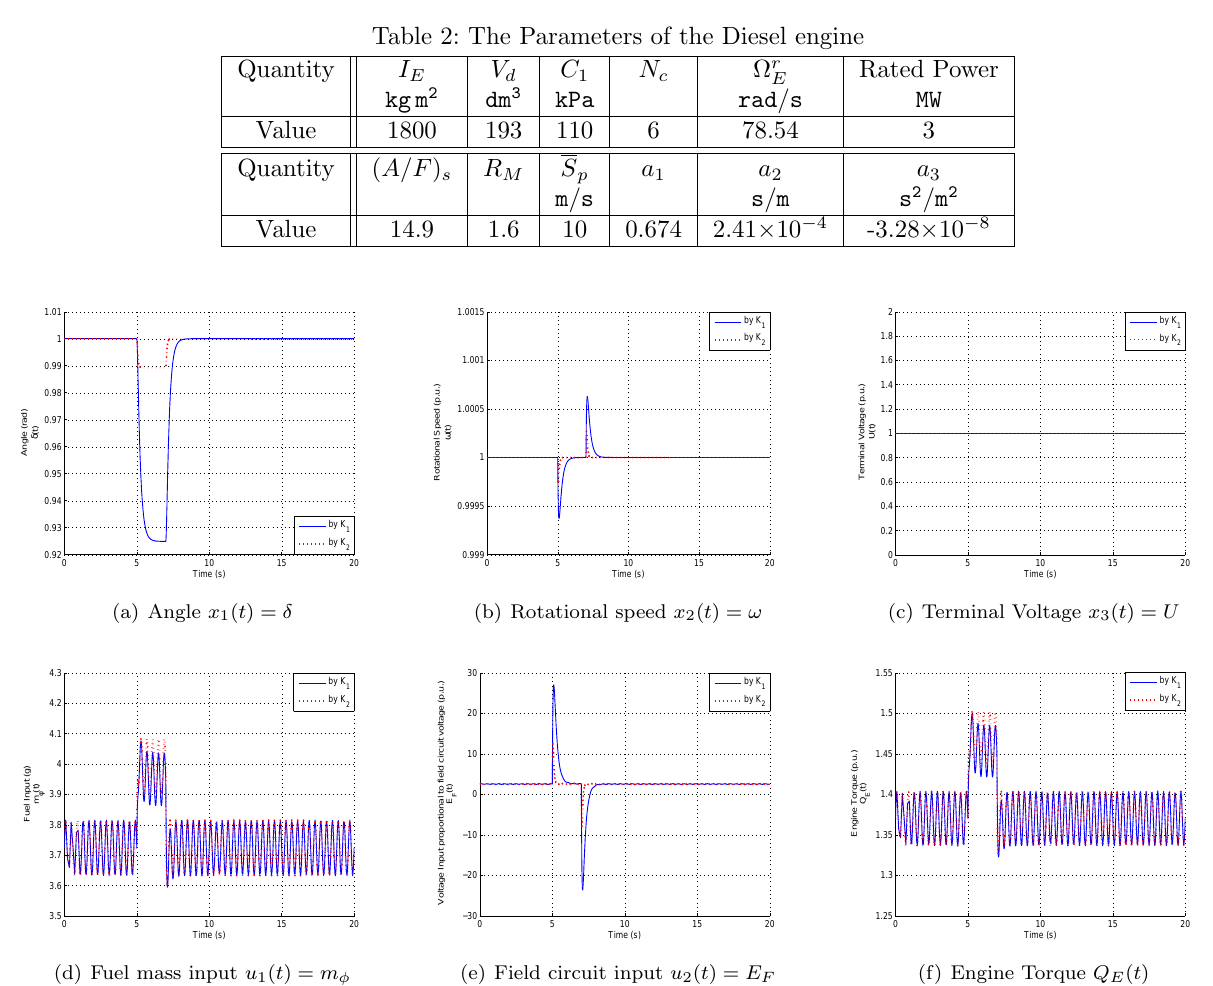
Figure 2: Results of the simulation of the model in eq.(40) with a sudden step in the load torque by the gains: K 1 (solid) and K 2 (dotted) all states are affected by this step because the cur- rent affects the electromagnetic torque and the termi- nal voltage. The gains K 1 and K 2 have almost the same controlling effect. Increasing the gain increases the fuel mass input m φ , and reduces the field circuit In this section, we discuss the performance of the pro- voltage E F . One more time, we see that the two input posed controller when the time delay and air/fuel ratio controls are reacting with each other to keep stability. are taken in